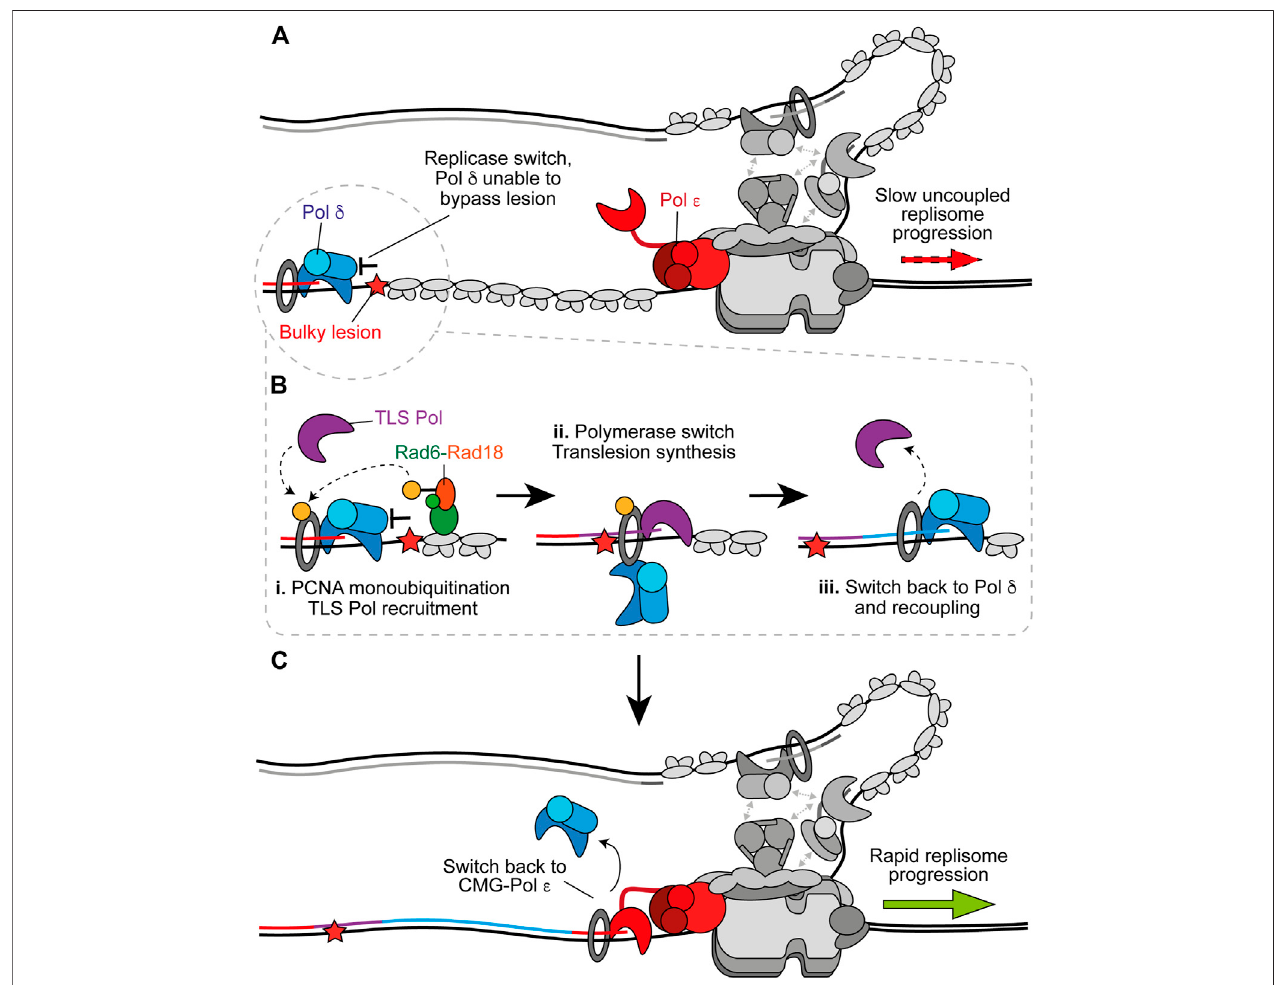
FIGURE4| On the fl y translesionsynthesis canpromote recoupling. (A) WhenPol δ isrecruited totheleading strand following uncoupling, but isunabletobypass the impediment, TLS is required prior to recoupling. Other replisome components are shown in gray for clarity. (B) i. RPA-coated ssDNA recruits Rad6-Rad18 which catalyse monoubiquitination of PCNA. This stimulates recruitment of a TLS polymerase. ii. The TLS polymerase extends the nascent strand past the impediment. This could occur without complete dissociation of Pol δ from PCNA. iii. After bypass a switch back to Pol δ facilitates rapid recoupling. (C) Pol δ hands the nascent leading strand back to Pol ε to restore canonical fork rates. Synthesis by Pol ε , Pol δ , and the TLS polymerase is shown in red, blue, and purple